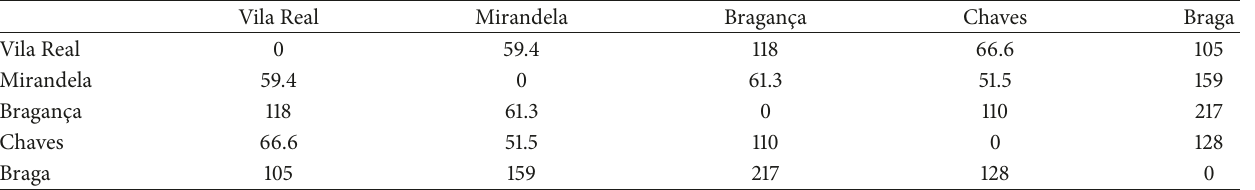
Table 1: Geographical distance (km) between the considered